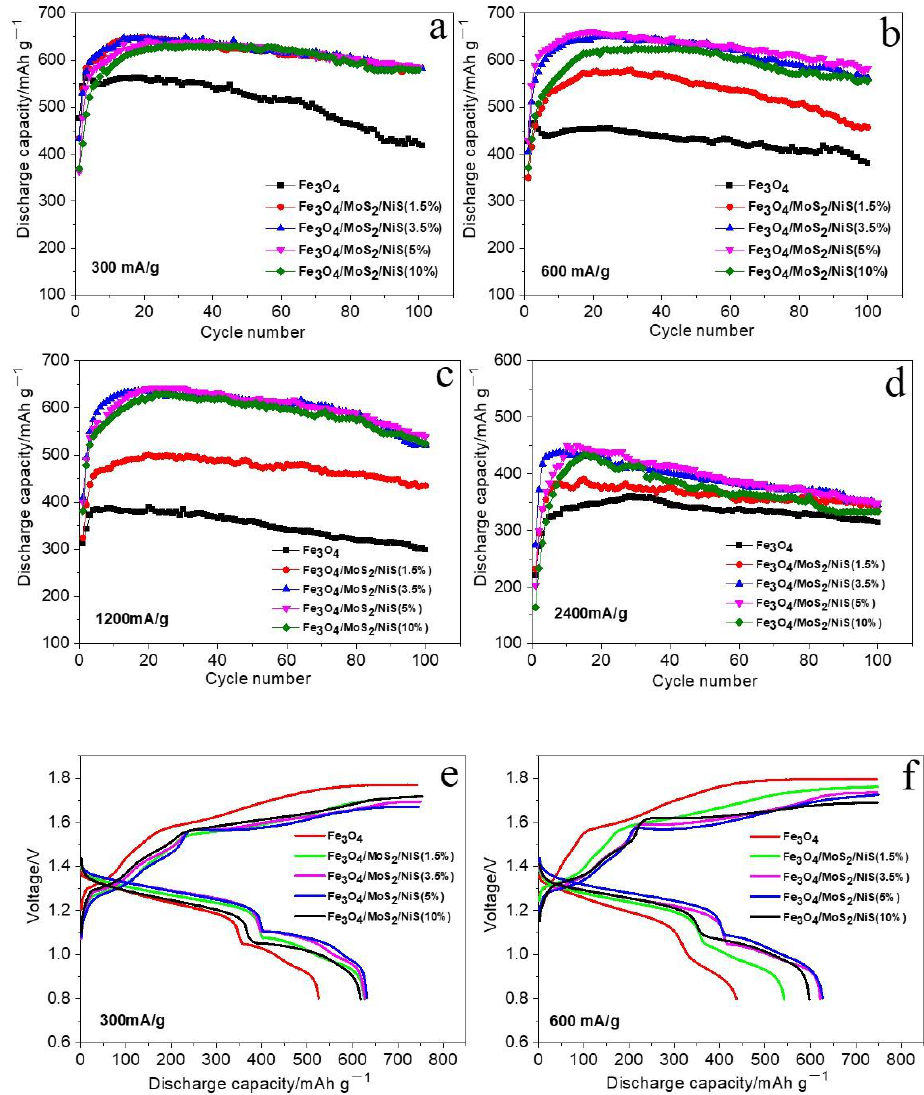
Figure 5. Cycle capacity plots and charging-discharging curves of Fe 3 O 4 , Fe 3 O 4 /MoS 2 /NiS (1.5%), Fe 3 O 4 /MoS 2 /NiS (3.5%), Fe 3 O 4 /MoS 2 /NiS (5%) and Fe 3 O 4 /MoS 2 /NiS (10%) electrodes at current density of 300 mA/g ( a,e ), 600 mA/g ( b,f ), 1200 mA/g ( c ) and 2400 mA/g ( d ) respectively.